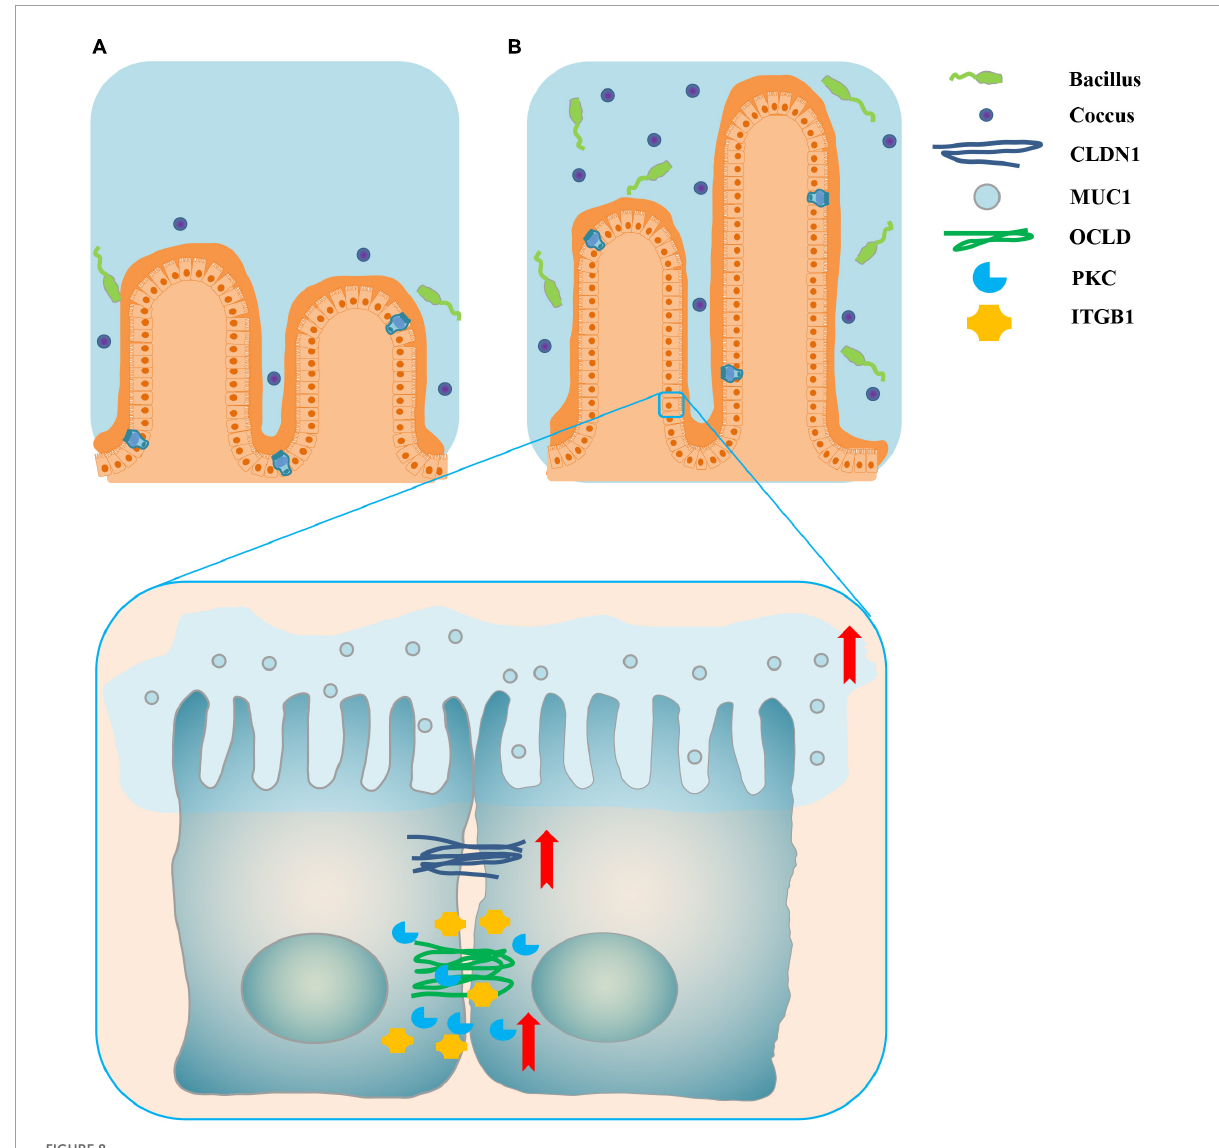
FIGURE8 Schematic representation of dietary supplementation of 0.2% sodium butyrate improves ileal mucosal barrier function in piglets. (A) The ileal mucosal barrier status in the INC group. (B) The promotion of ileal mucosal barrier function by sodium butyrate in IS. The red arrows indicate that the relative mRNA expressions of ileal barrier functional proteins are significantly upregulated. Dietary supplementation of 0.2% sodium butyrate significantly increased the villus height of the ileum, upregulated the relative mRNA expressions of the ileal barrier functional gene, and increased the relative abundance of some probiotics such as Lactobacillus , Streptococcus , and Blautia